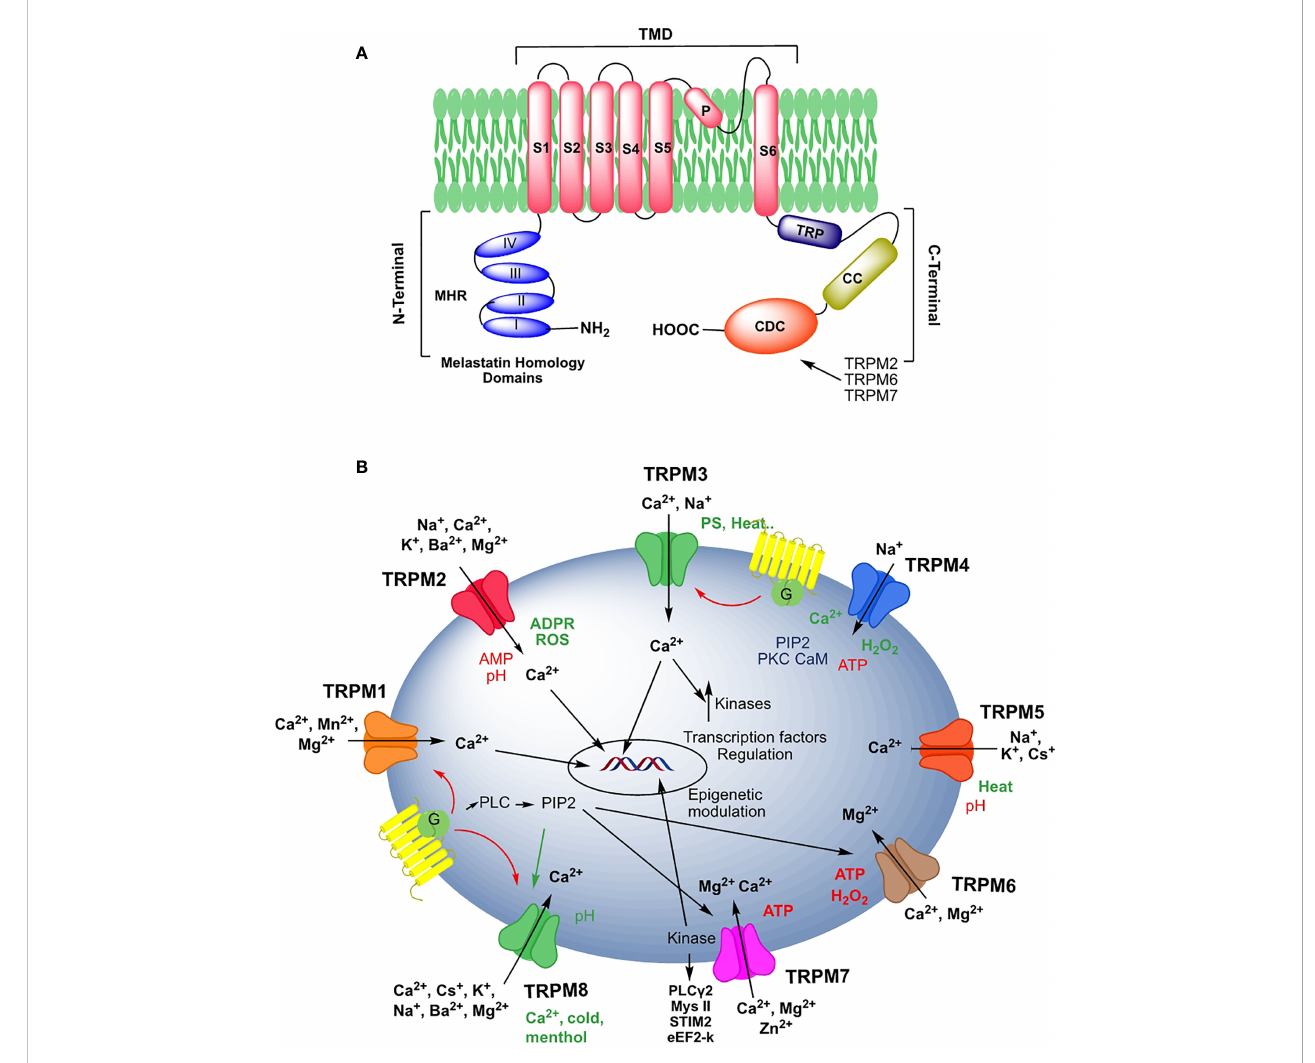
FIGURE 1 (A) Schematic representation of the structural domains of a monomer of the human TRPM family according to the design of Hang et al. (9). (B) . Schematic illustrations of ion permeabilities and regulation processes of TRP channels. Color codes, red: channel inactivators; green: channel activators. The designs have been made using Chem Draw Professional